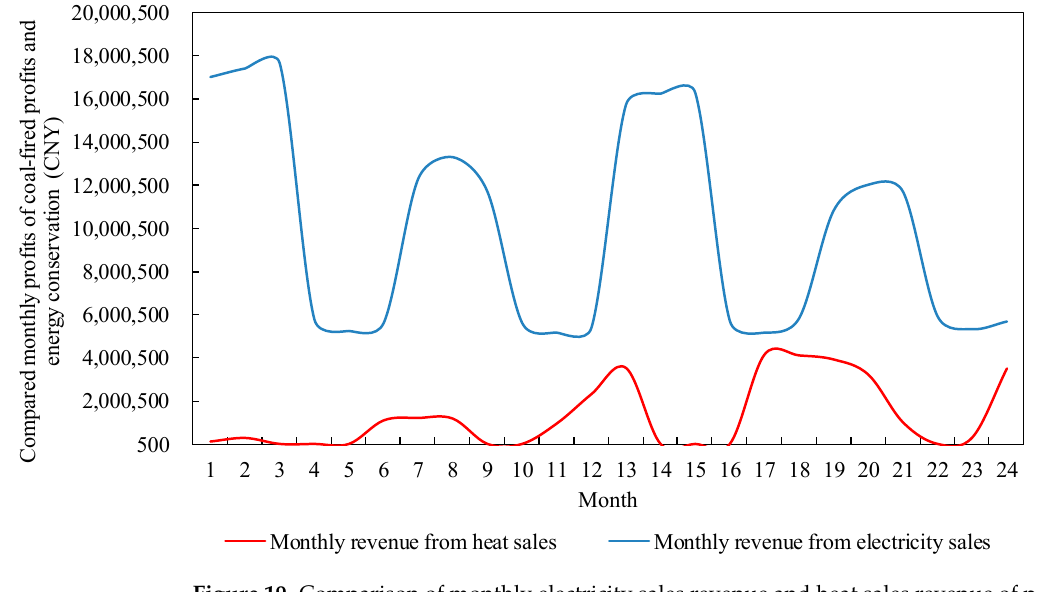
Figure 19. Comparison of monthly electricity sales revenue and heat sales revenue of power retailers.